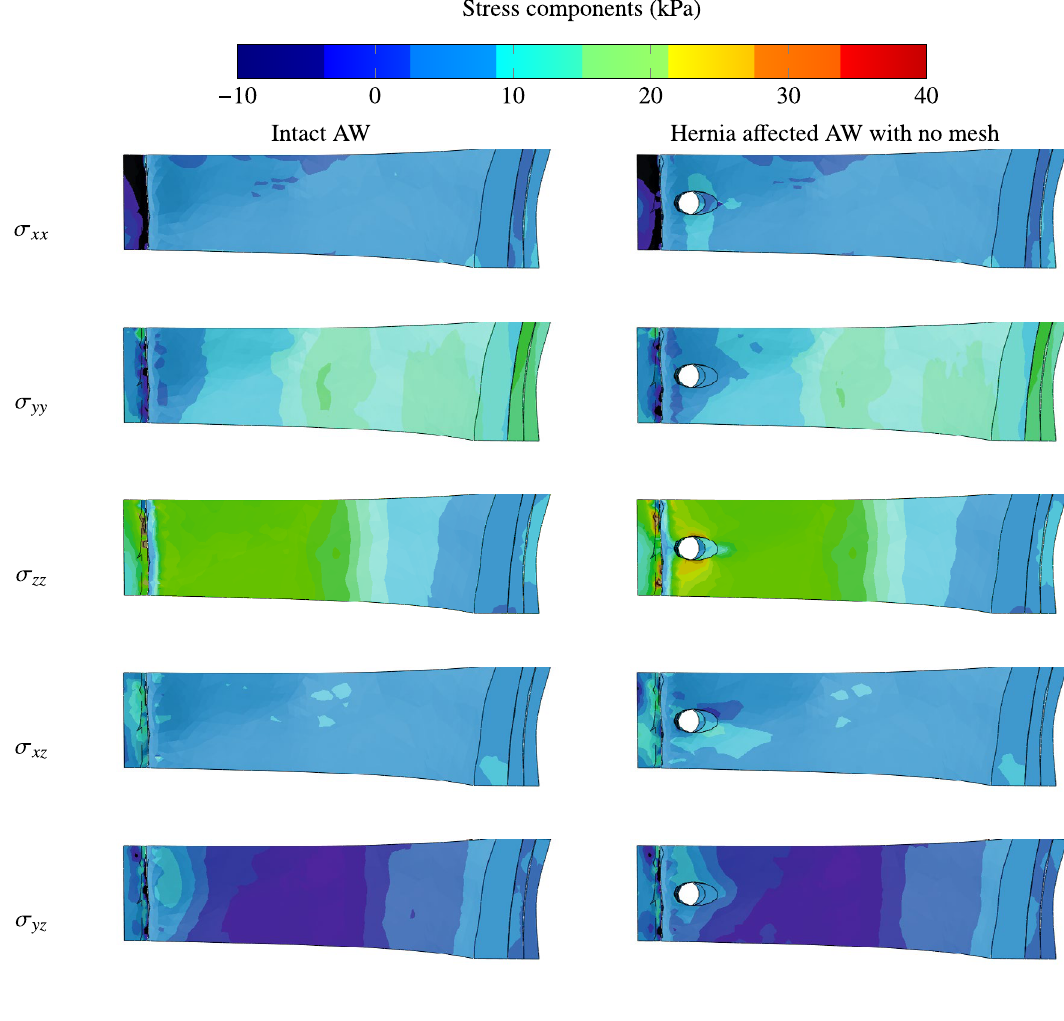
Figure 6. Contours of stress components for intact AW and hernia affected AW when no mesh is used to reinforce the damaged muscles. The sixth shear component stress tensor σ xy has been ignored because it is